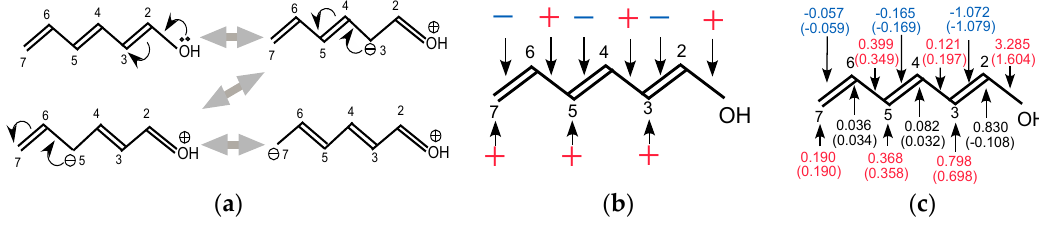
Figure 8. ( a ) Resonance structure of hexa-1,3,5-trien-1-ol molecule; ( b ) Expected fluctuations of charges and bond-orders; ( c ) LRF-D and LRF-BO values for which the perturbation is applied to the oxygen atom.